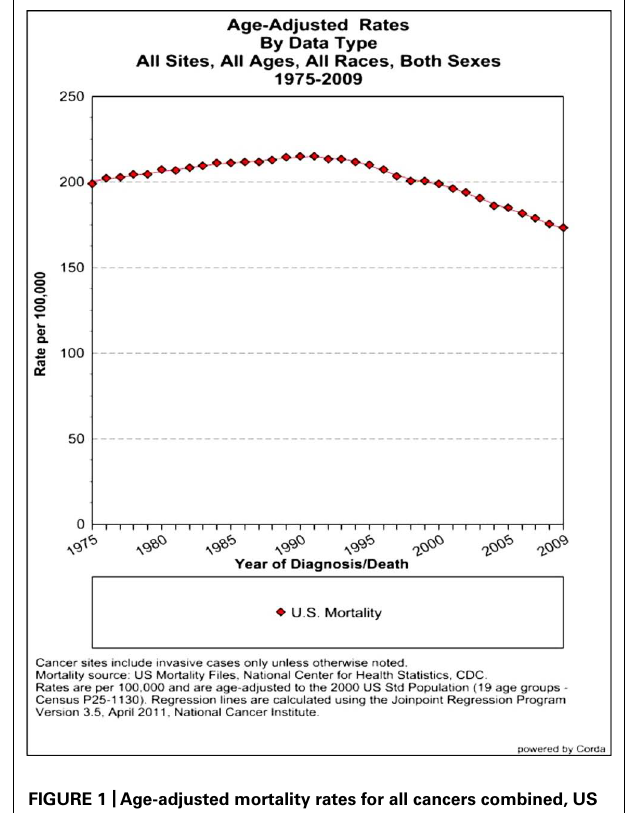
FIGURE 1 |Age-adjusted mortality rates for all cancers combined, US SEER data (Howlader etal., 2011).